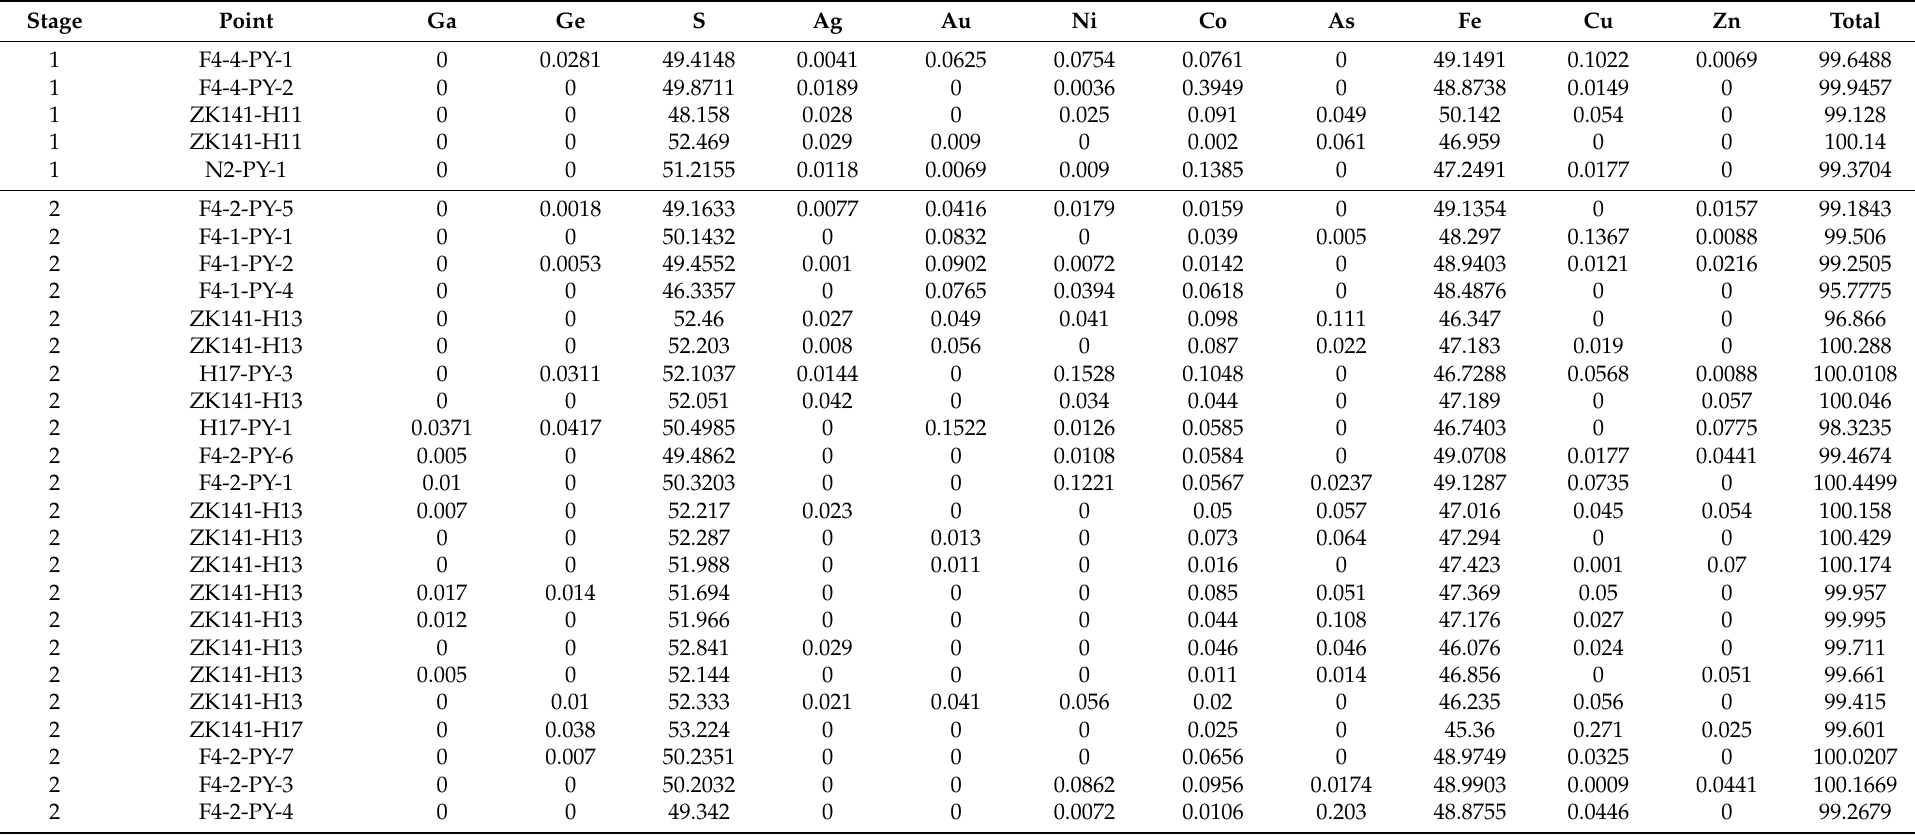
Table 1. Microprobe compositions of pyrites from Fang’an gold